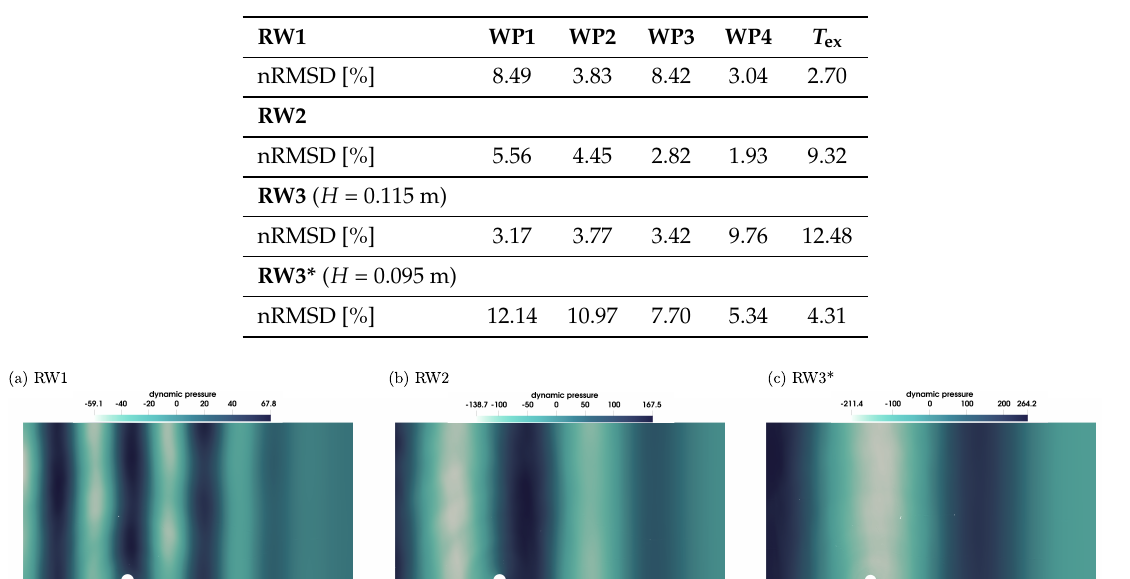
Figure 12. Phase-averaged free surface elevation, measured at wave probes WP1–WP4 ( a – d ), and wave excitation torque ( e ) for wave RW3*. Table 5. nRMSD between the experimental and numerical free surface elevation and excitation torque for waves RW1–RW3.